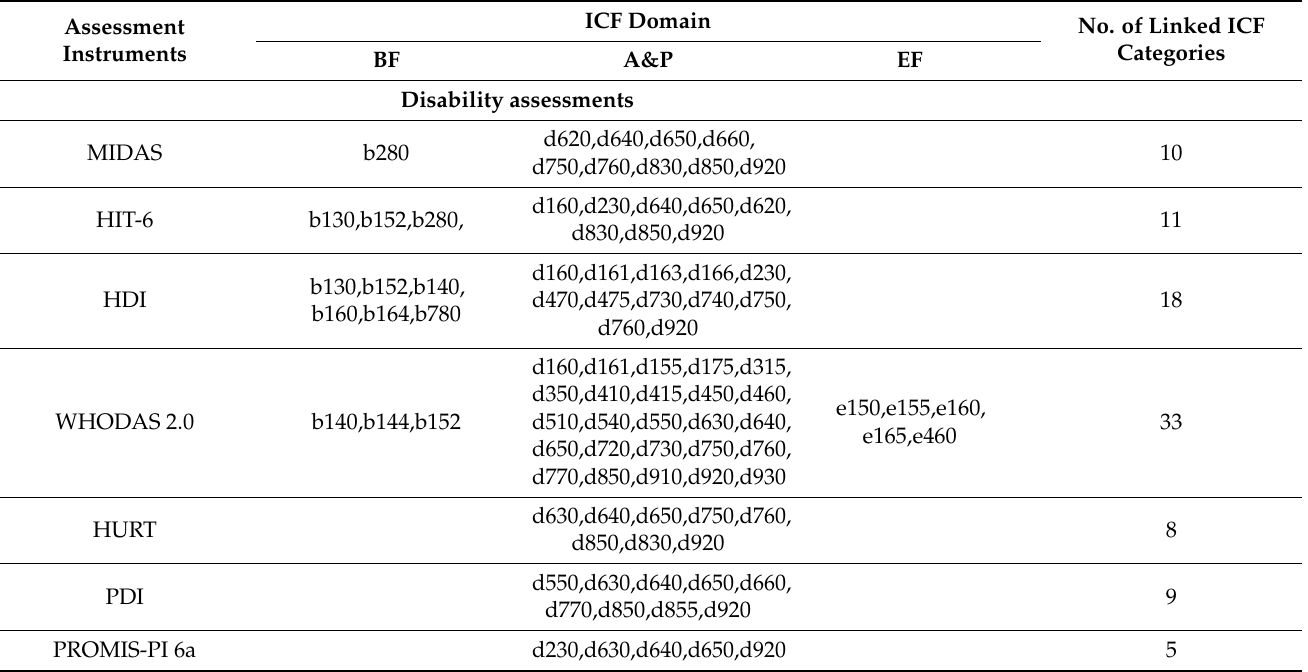
Table 2. The International Classification of Functioning, Disability, and Health (ICF)-linked categories by domain for each assessment